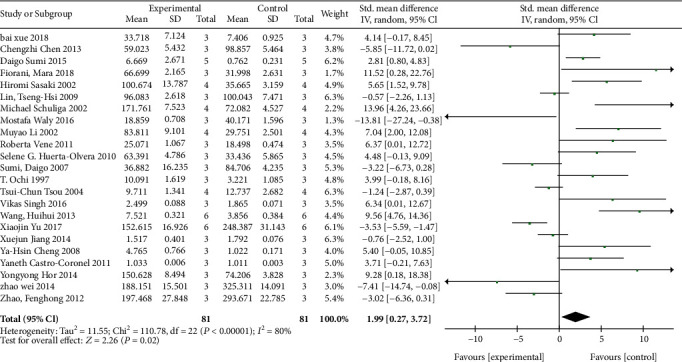
Meta-analysis of the effects of arsenic exposure on GSH in vitro. The forest plot shows the effect of arsenic treatment on GSH in experiment and control group. SMD: standardized mean difference; IV: independent variable; 95% CI: 95% confidence interval; SD: standard deviation. The P value of the overall test effect is 0.02; when P < 0.05, the difference was considered statistically significant.